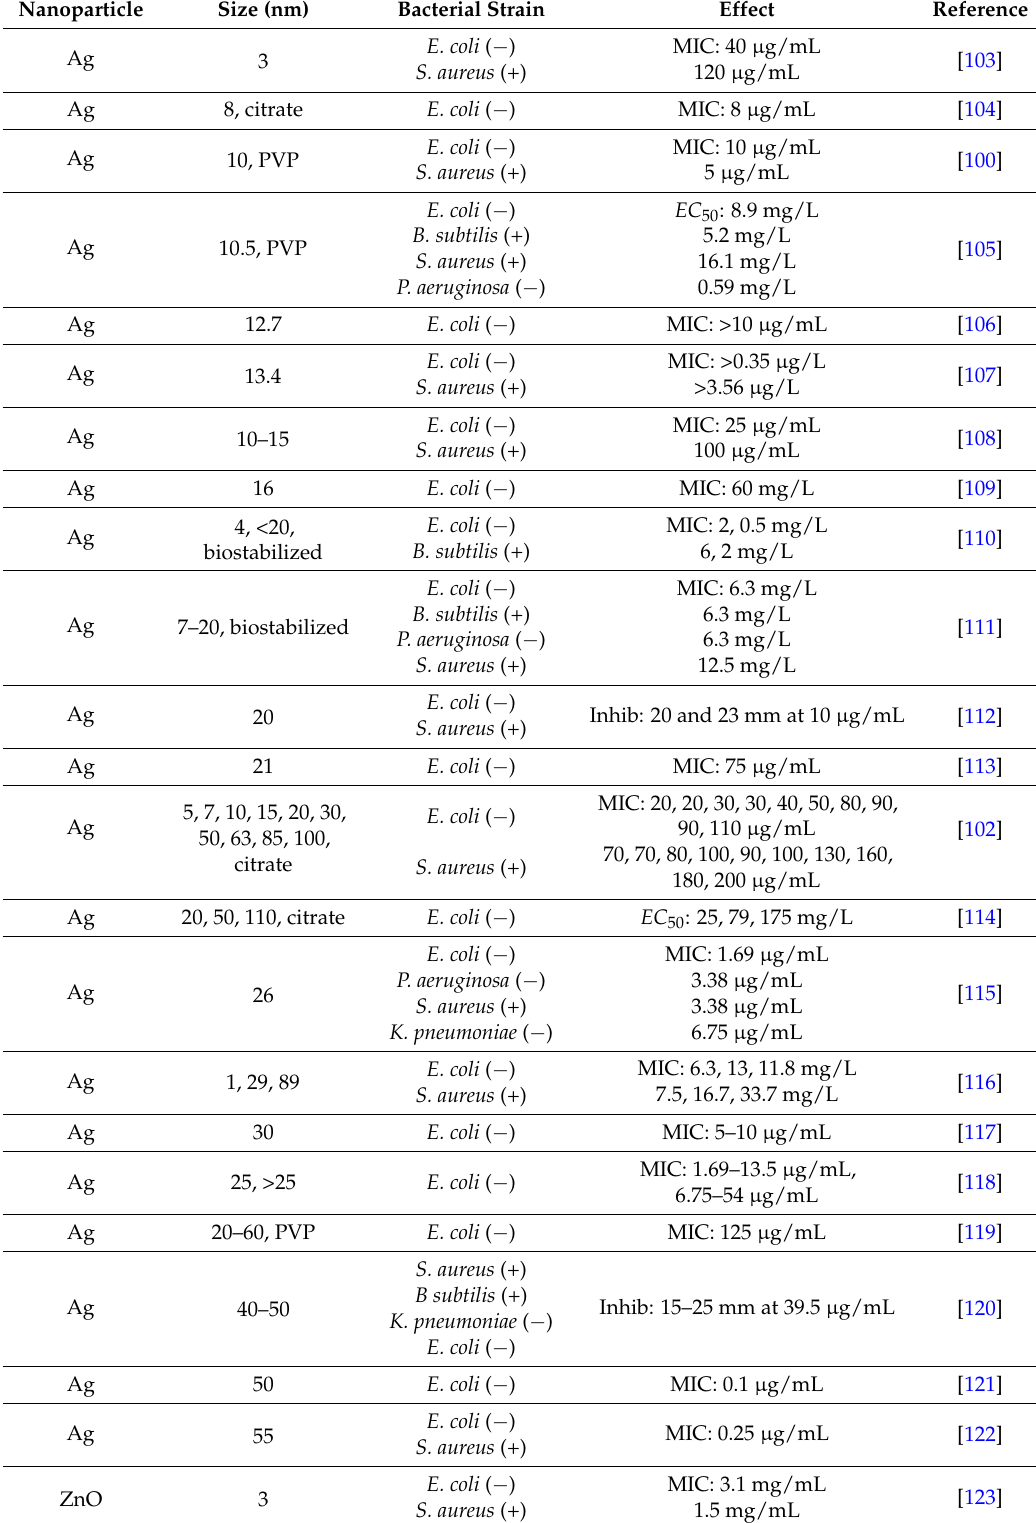
Table 1. Toxic action of Ag and ZnO NPs on E. coli compared to other gram-positive (+) and gram-negative ( ´ ) bacteria and on human intestinal cell lines. Stabilizers of the particles are indicated, when mentioned in the respective